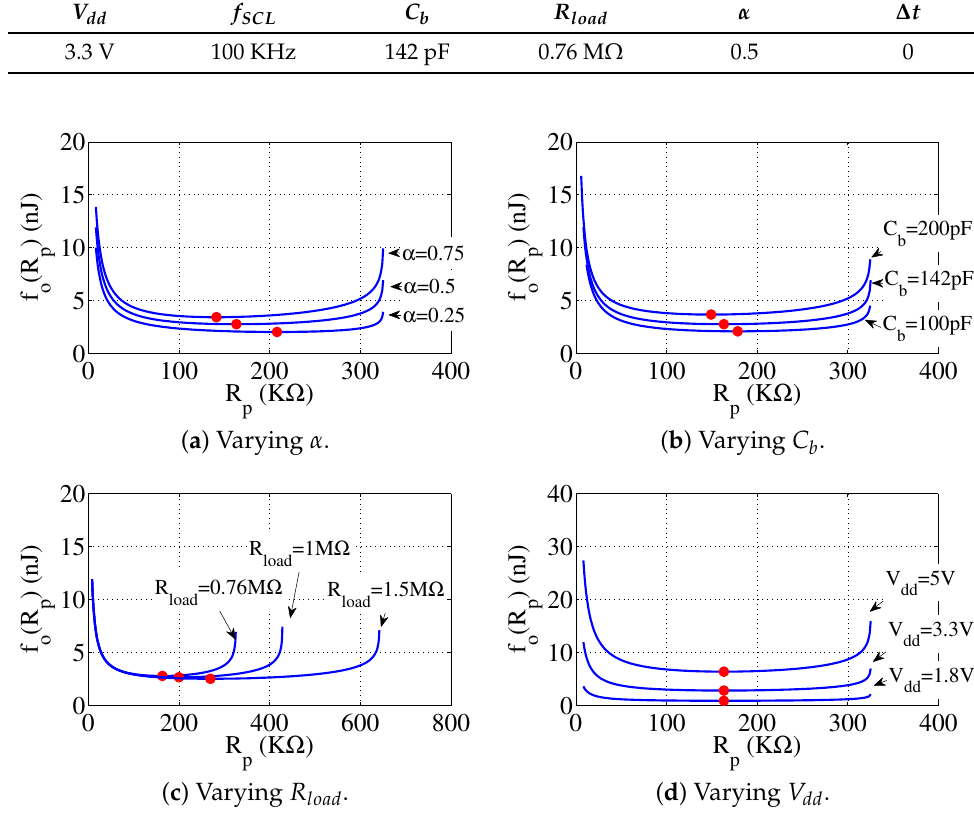
Figure 12. The simulation results of optimal resistance values over different parameters. Each optimal value is marked by a red point. f o ( R p ) represents the average bit energy budget. In ( a ) and ( b ), the optimal R p decreases along with the increase of α and C b , respectively. In ( c ), R load does not change the curve on the ordinate and just prolong the curve on the abscissa. In ( d ), higher V dd will not impact the optimal R p value and only introduces higher power consumption. As f o ( R p ) is almost same when R p = 100 K Ω to 250 K Ω in ( a )–( d ), we recommend an empirical value R p = 100 K Ω as a general resistance